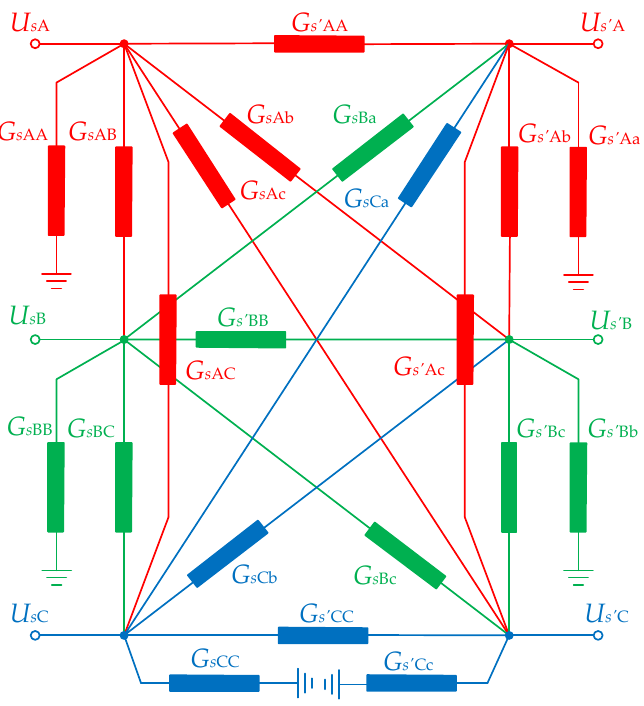
Figure 3. The equivalent decoupled circuit for the ST.